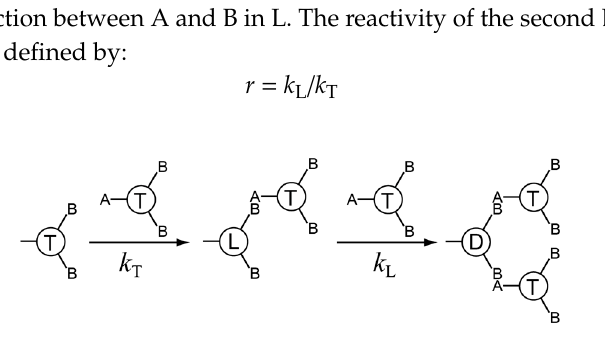
Figure 1. Reaction scheme for the step growth polymerization of AB 2 type monomer.